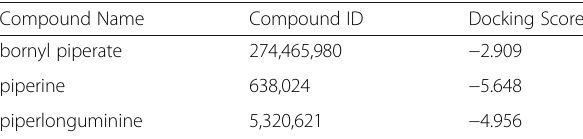
Table 4 Docking result of bornyl piperate, piperine and piperlonguminine with COX-1 (PDB: 2OYE)